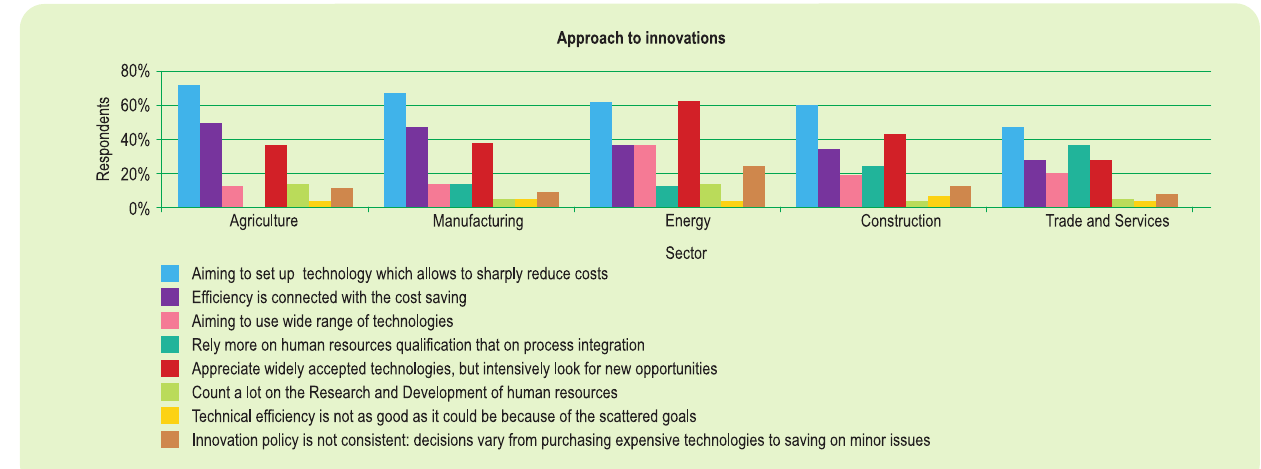
Fig 5 . Innovation strategies of businesses with no